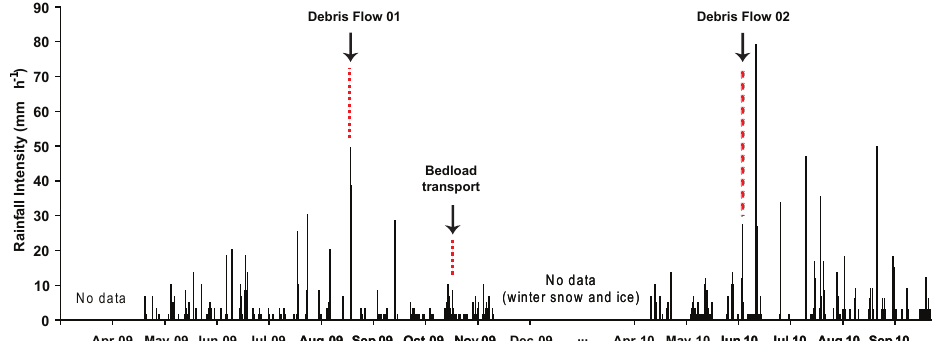
Figure 3. Maximum rainfall intensity over the monitoring period measured by a rain gauge located at the top of the torrent (see Fig. 4) and calculated for a 5min time interval. The mean annual precipitation is about 1500mm in the headwater of the Manival (modified from Loye, 2013).